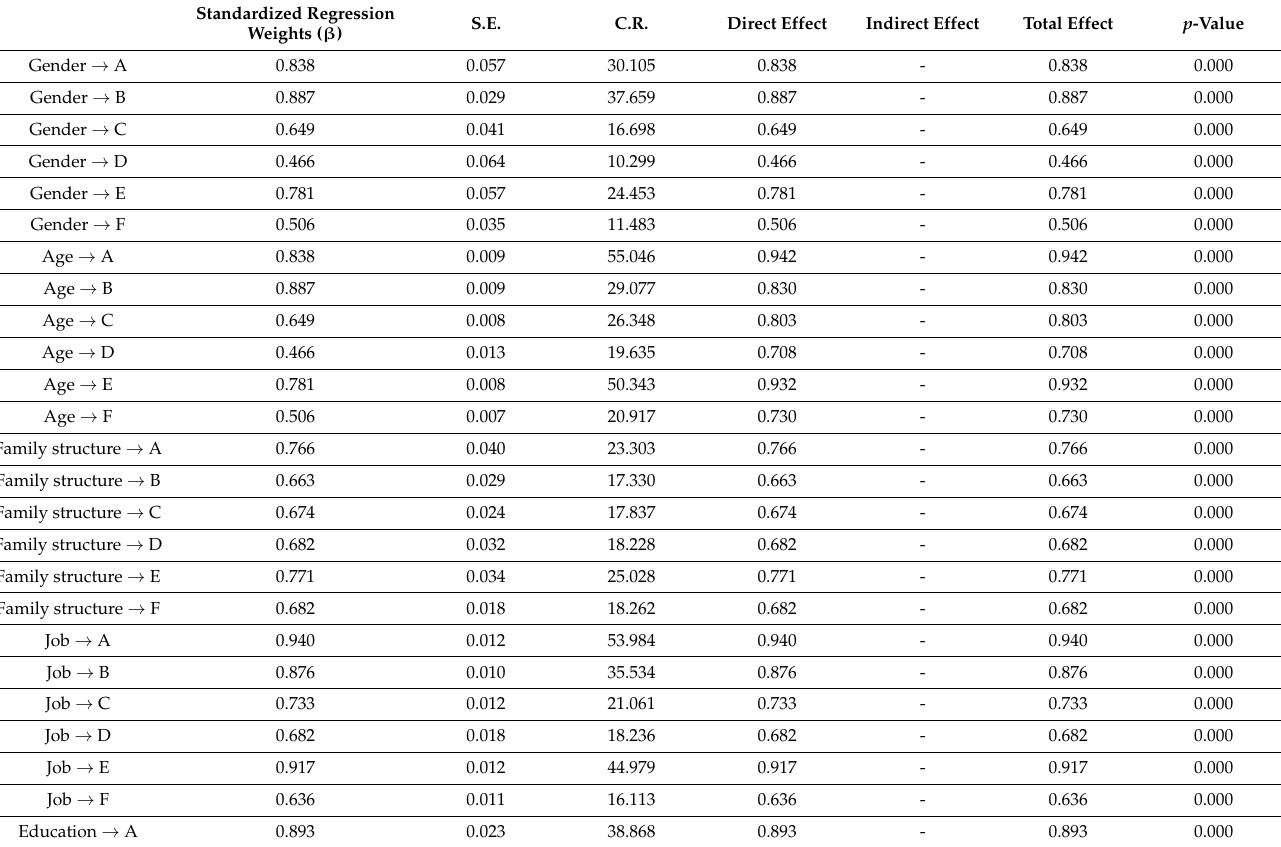
Table 11. The results of testing the impacts of sociodemographic characteristics on TBCs in the structural equation